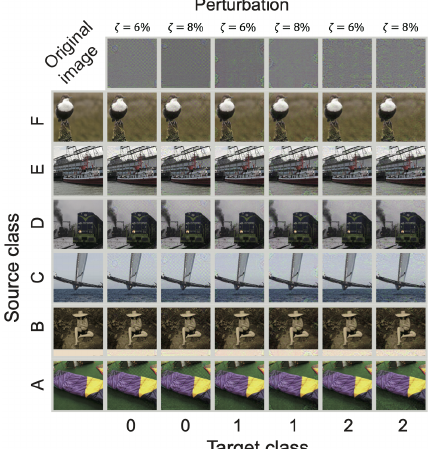
Figure 3. Targeted UAPs (top panel) against the ResNet-50 model for the ImageNet dataset and their adversarial attacks for the original (i.e., non-perturbed) images (left panel) randomly selected from the images that, without perturbation, were correctly classified into the source class and, with the perturbation, correctly classified into each target class under the constraint that the source classes are not overlapping each other and with the target classes. The source classes displayed here are sleeping bag ( A ), sombrero ( B ), trimaran ( C ), steam locomotive ( D ), fireboat ( E ), and water ouzel, dipper ( F ). The target classes are golf ball (0), broccoli (1), and stone wall (2). The UAPs with ζ = 6% and ζ = 8% are shown. Note that the UAPs are emphatically displayed for clarity; in particular, each UAP was scaled with the maximum of one and the minimum of